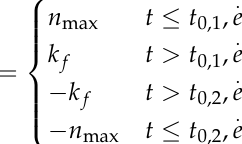
where t 0,1 is the delay time after adding the opposite load, calculated according to Equations (32) and (33) and t 0,2 is the delay time after adding the aiding load. Figure 28 shows the control effect under a 5 MPa unidirectional load after the controller parameters are modified.